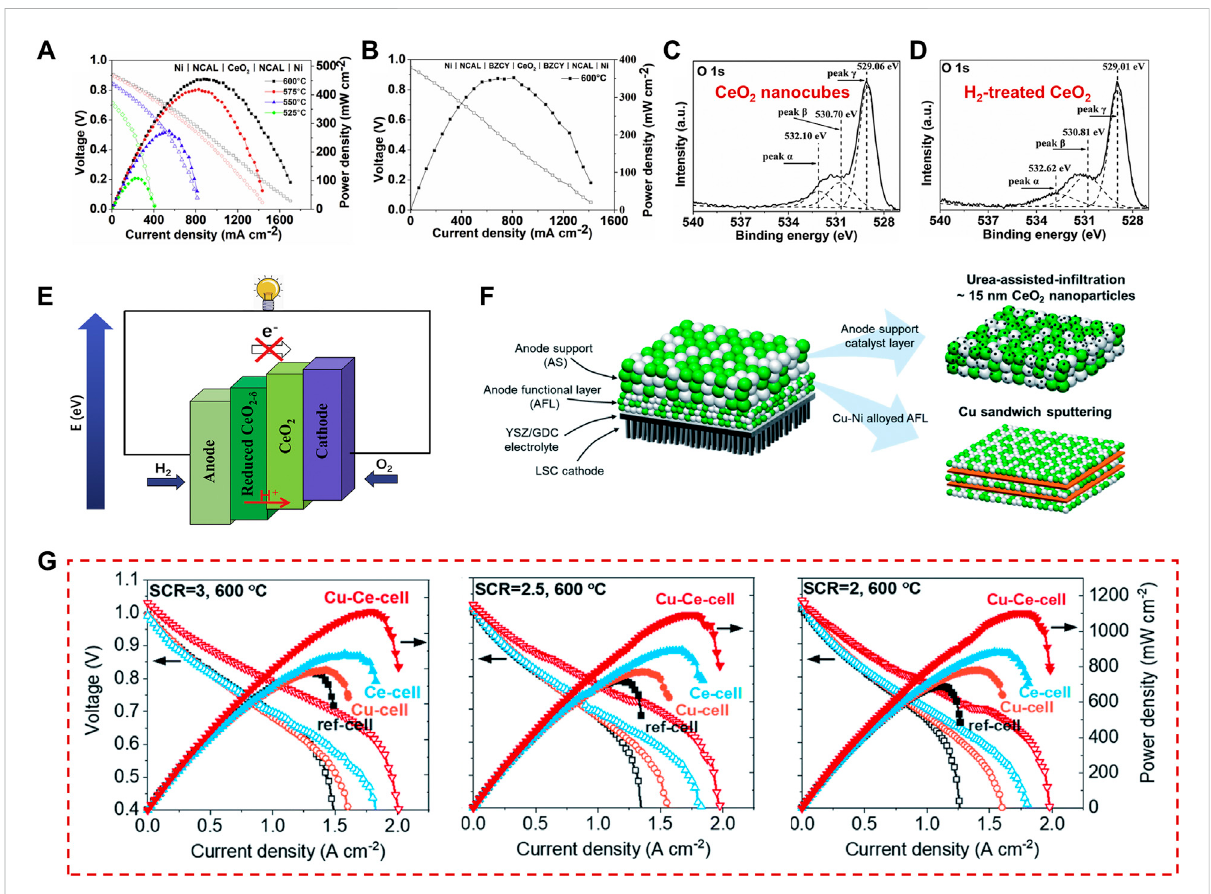
FIGURE 11 CeO 2 -introducted electrolyte and electrode of SOFCs: (A – E) CeO 2 nanocubes electrolyte and design of the CeO 2 /CeO 2- δ heterogeneous interfaces. Reproduced with permission (Li et al., 2018). Copyright 2018, Elsevier. (F,G) The con fi guration and CeO 2 -based catalyst incorporation strategies in a TF-SOFC and the obtained fuel cell performance. Reproduced with permission (Thieu et al., 2022). Copyright 2022, Royal Society of